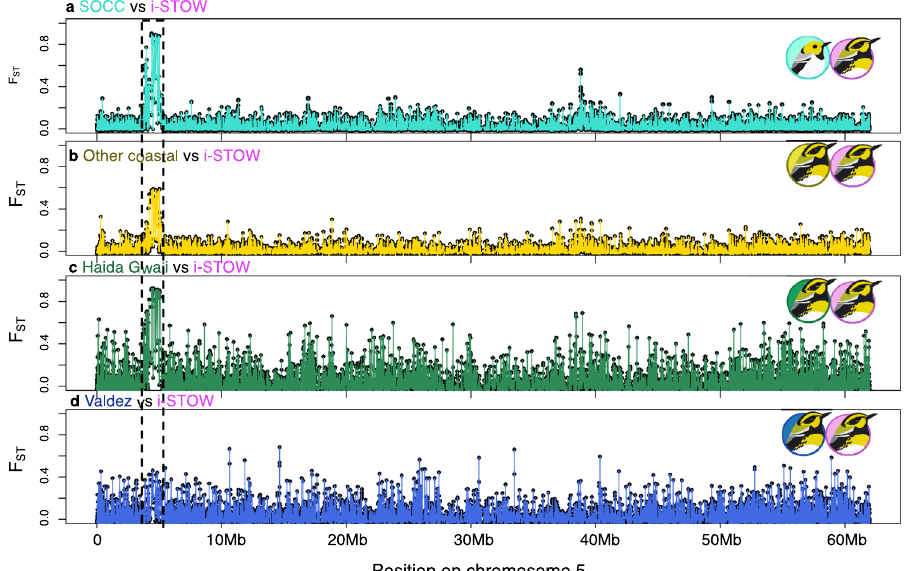
Fig. 3 Semi-parallel differentiation of SOCC and various coastal STOW from inland STOW in a chr5 gene block (dotted box). Genetic differentiation ( F ST ) of variable sites along chromosome 5, between four pairs of populations, where S. occidentalis (SOCC), inland S. townsendi (i-STOW) were respectively color-represented by turquoise and magenta ( a ), and various coastal S. townsendi (coastal STOW) populations were color-represented in gold ( b for other coastal STOW in Fig. 1d), forest green ( c for Haida Gwaii coastal STOW), and royal blue ( d for Valdez coastal STOW), respectively. Bird illustrations by Gil Jorge Barros